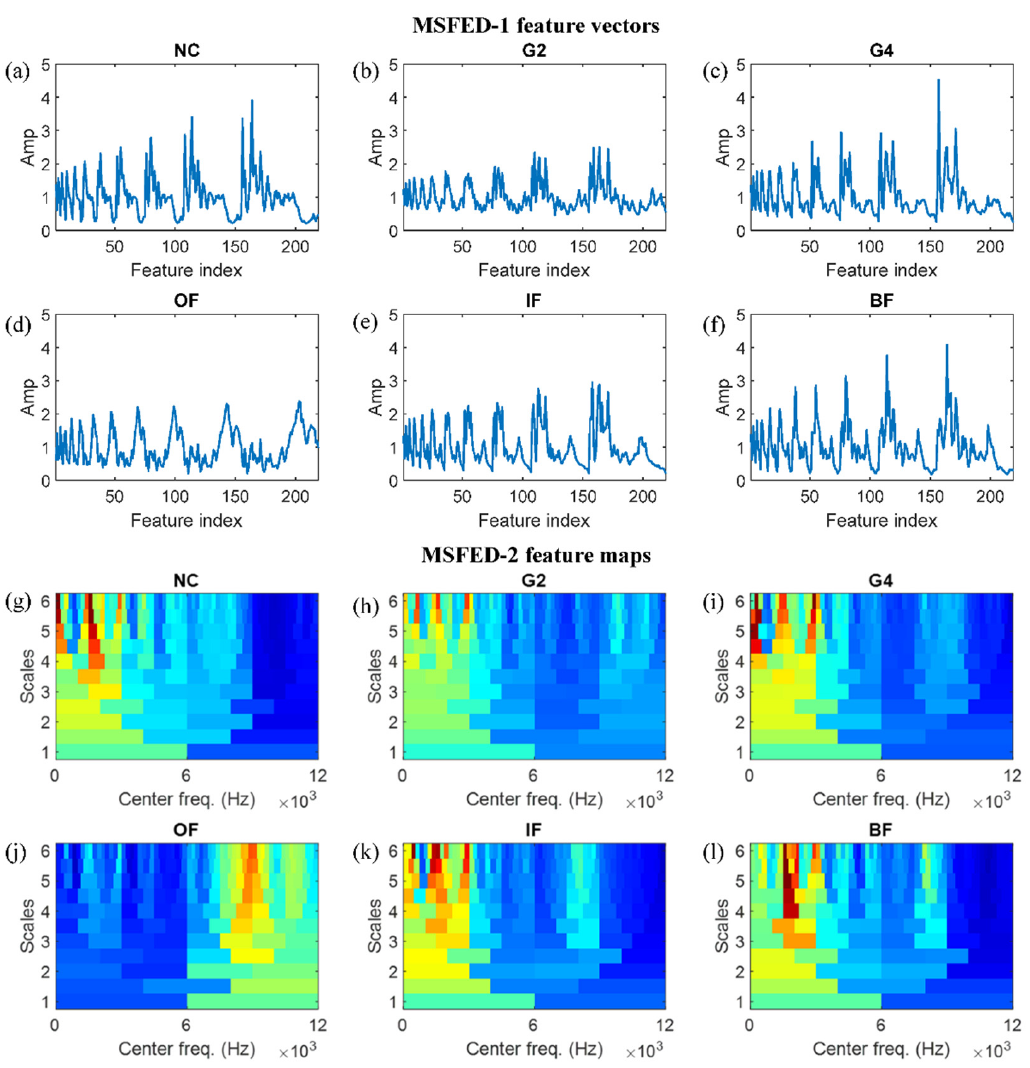
Figure 4. The MSFED-1 feature vectors and MSFED-2 feature maps of vibration samples at 1000 rpm: ( a – f ), The MSFED-1 features of NC, G2, G4, OF, IF, and BF samples, ( g – l ), The MSFED-2 features of NC, G2, G4, OF, IF and BF samples.